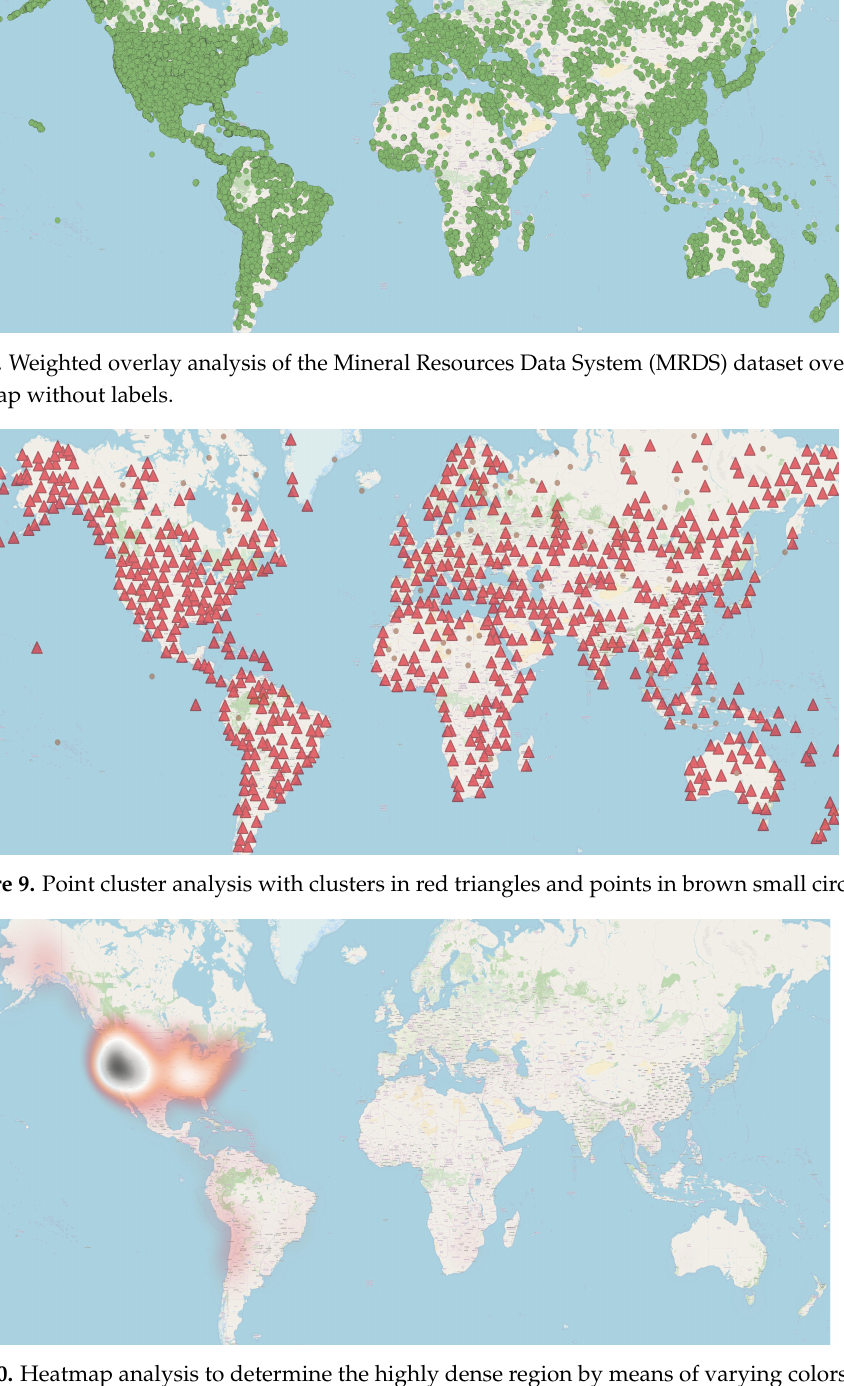
Figure 10. Heatmap analysis to determine the highly dense region by means of varying colors as per the